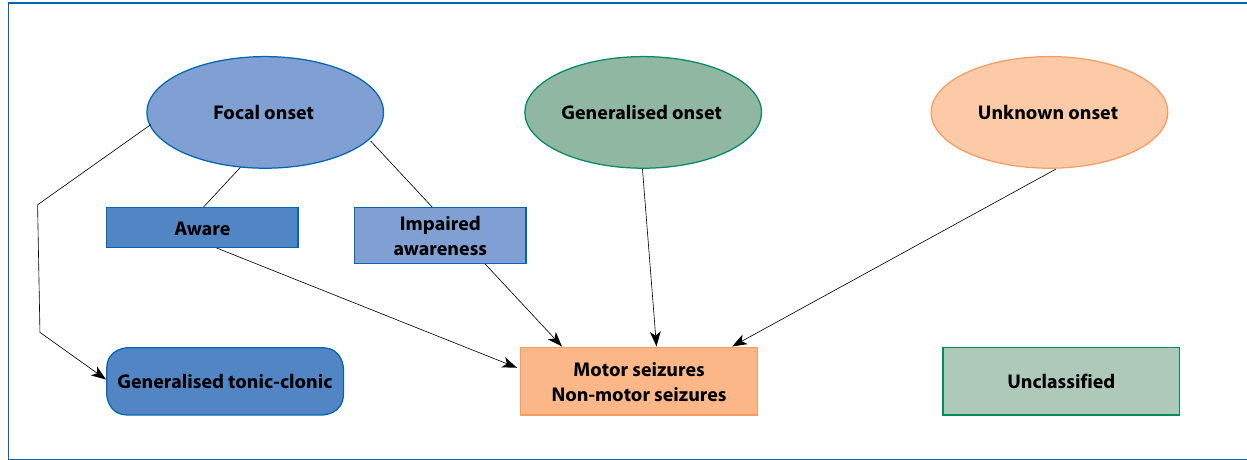
Figure 1. ILAE 2017 Classification of Seizure Types Basic Version (please refer to the various seizures types discussed above for